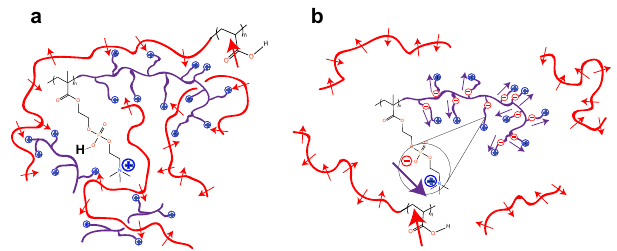
Fig. 7 Mechanism for pH-dependent phase behavior of pMPC-pAA complexes. Dipolar pAA chains are depicted in red, and the polyampholyte pMPC is drawn in purple. The corresponding charges of each chain are drawn as red negative symbols and blue positive symbols. In the case of pMPC, charges are tethered to monomers further from the chain backbones, and are therefore drawn as appendages, with the negative charge proximal to the backbone, and the positive charge distal to it. pAA chains can be more closely approximated simply as a line of dipoles due to their smaller monomer size, and much larger chain length. a pH < 4: The ionization equilibrium favors the protonation of the pMPC phosphate groups, which confers a formal charge of + 1 for each pMPC monomer. In this scenario, the exposed positive charges on pMPC can interact with dipoles along the pAA chains, promoting complexation, and accompanied by counterion release. b pH > 4: the phosphoryl groups of the pMPC are mostly deprotonated, effectively neutralizing the positive charge on the choline group. In this state the net charge of each pMPC monomer is zero, and thus there is no favorable interaction promoting association with pAA, owing to the relative weakness of the dipole-dipole interaction compared to the charge-dipole interaction.